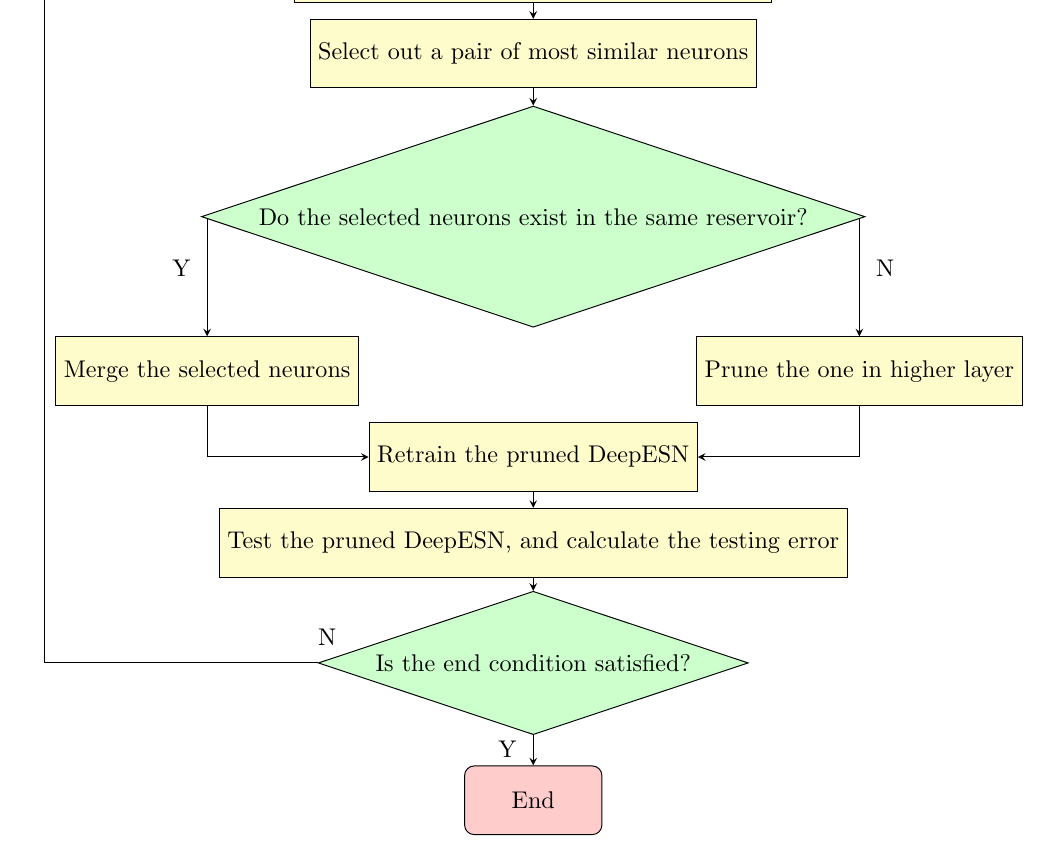
Figure 4. Flowchart of